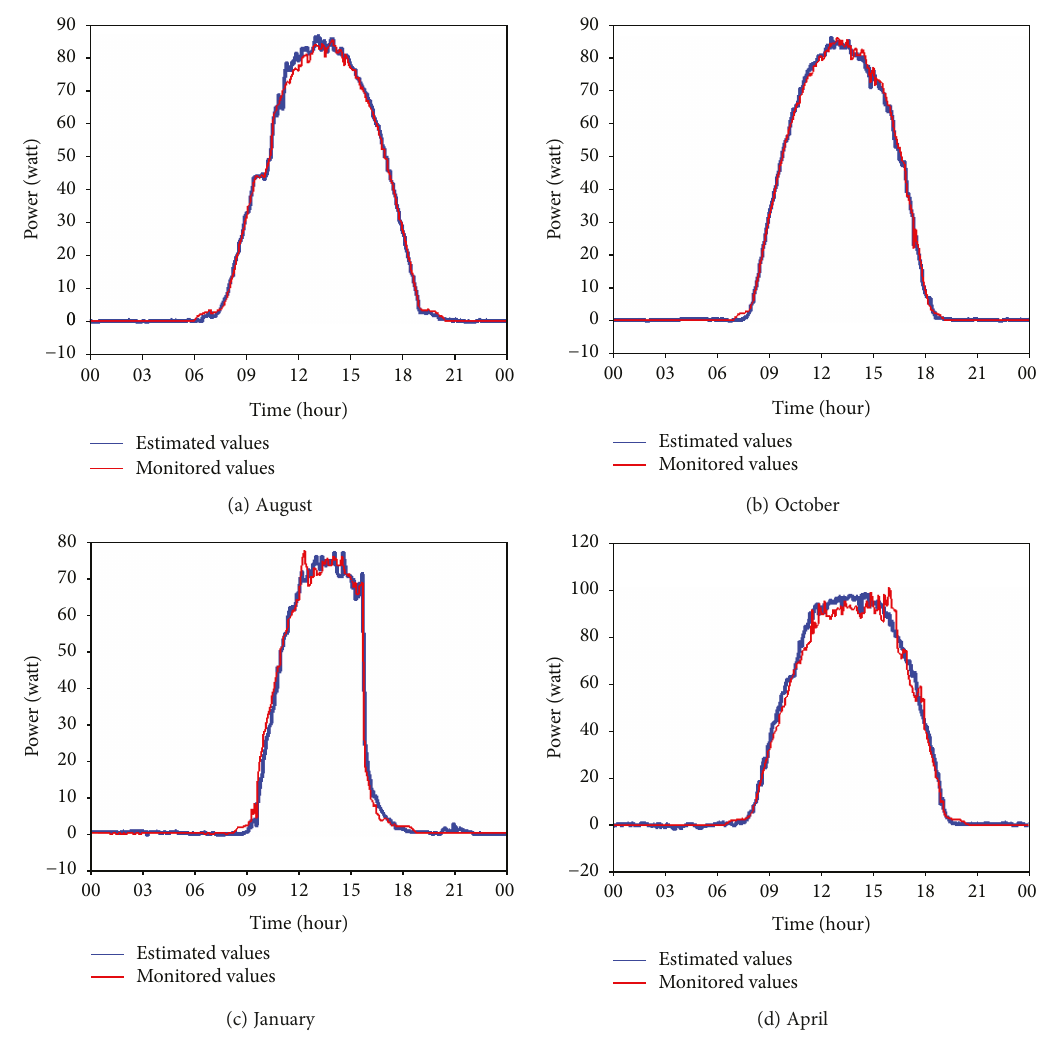
Figure 5: Sample estimation graphs for